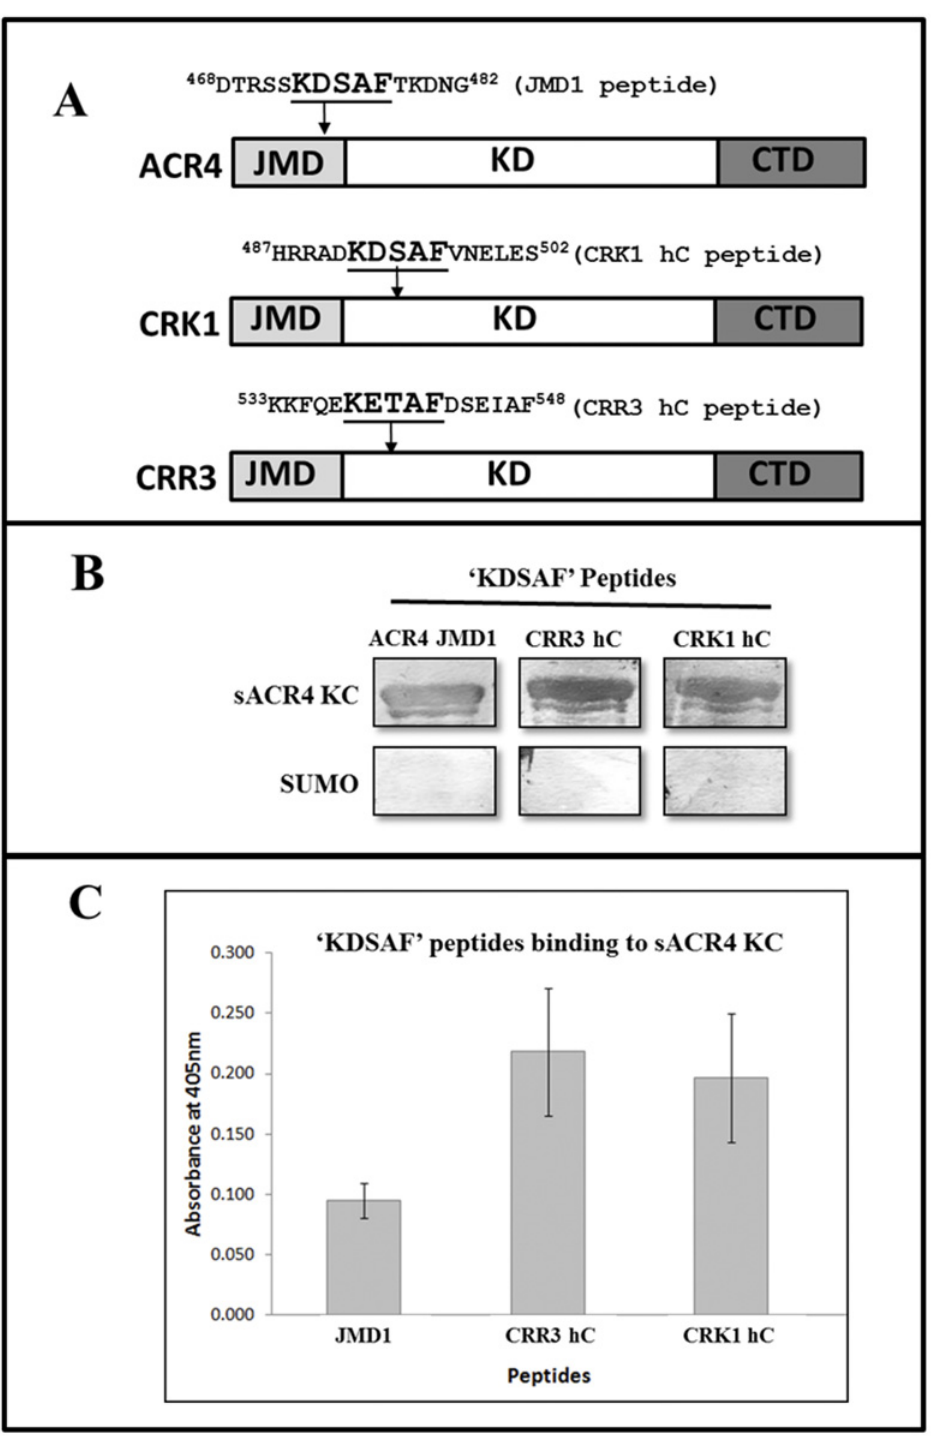
Fig 5. ‘ KDSAF ’ peptides bind to the ACR4 kinase. (A) Schematics of the ACR4, CRK1 and CRR3 amino acid sequence. The location of the “ KDSAF ” motif sequence in the domain architecture of the respective proteins is indicated by an arrow. (B) The ‘ KDSAF ’ motif containing peptides were incubated with the sACR4 KC protein to demonstrate specificity of binding towards the ACR4 kinase. A peptide overlay assay showing that the unphosphorylated JMD1 [26], the CRR3 hC and CRK1 hC peptides can bind to sACR4 KC ( upper panel ). Control blots show no specificity towards the SUMO solubility tag ( lower panel ). (C) Peptide binding assay demonstrating the ‘ KDSAF ’ containing peptides can bind to the natively folded sACR4 KC protein immobilized on a Ni 2+ coated